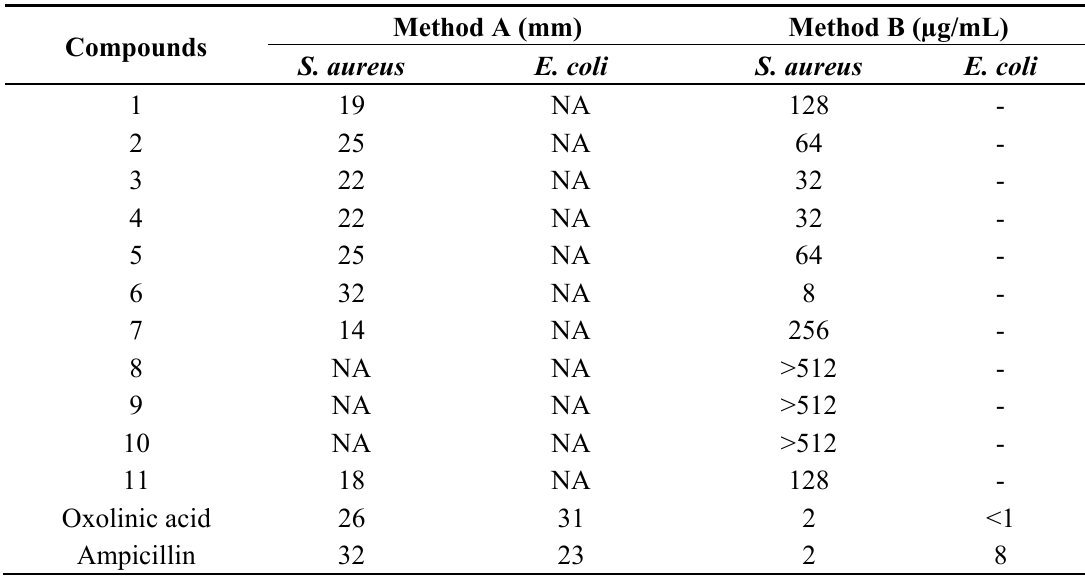
Table 1. In vitro antibacterial activity a of amino/nitro substituted 3-arylcoumarins 1 – 11 ( A ) expressed as inhibition zones (mm) b and ( B ) expressed as MICs